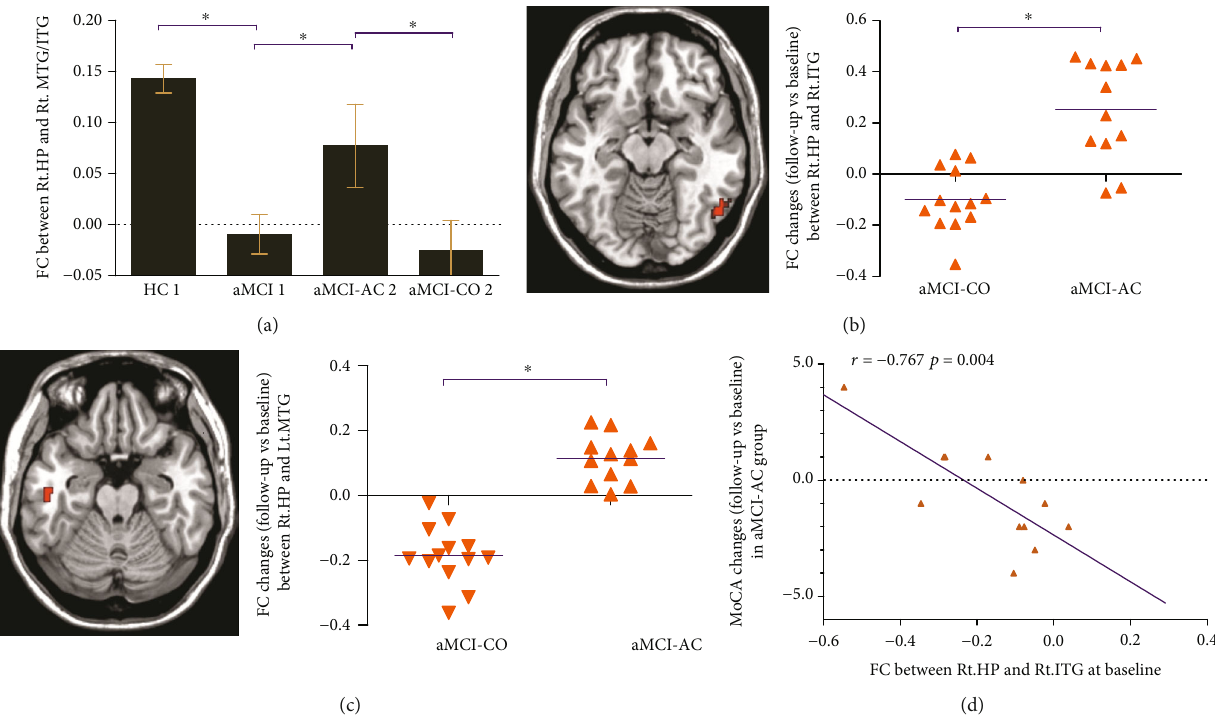
Figure 3: (a) The value of FC between the right HP and right MTG/ITG in HC at baseline, aMCI at baseline, aMCI acupuncture at follow-up, and aMCI control at follow-up. (b) Increased FC between the right HP and right ITG in aMCI acupuncture subjects as compared to aMCI control at follow-up vs. baseline (interaction e ff ect). (c) Increased FC between the right HP and left MTG in aMCI acupuncture subjects as compared to aMCI control at follow-up vs. baseline (interaction e ff ect). (d) Linear correlation of longitudinal changes in MoCA scores and the FC between the right HP and the right ITG at baseline in aMCI acupuncture subjects. HC 1: healthy control participates at baseline; aMCI: amnestic mild cognitive impairment; aMCI 1: all aMCI subjects at baseline; aMCI-AC 2: aMCI acupuncture group at follow-up; aMCI-CO 2: aMCI control group at follow-up; FC: functional connectivity; HP: hippocampus; Lt.: left; Rt.: right; MTG: middle temporal gyrus; ITG: inferior temporal gyrus; ∗ indicates cluster-level p < 0 : 05 , FDR